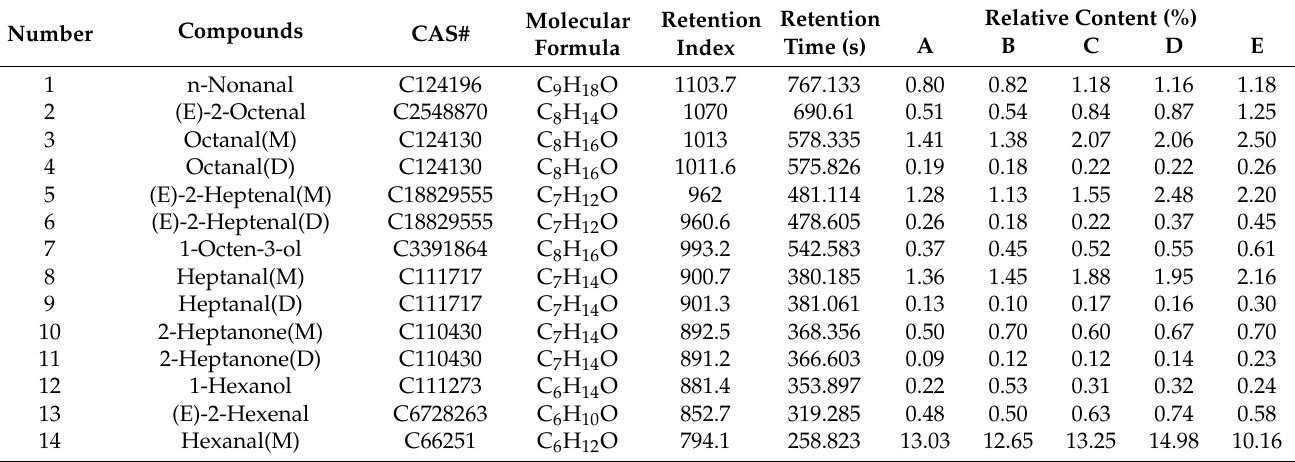
Table 1. Relative content of VOCs in walnut oil from five different